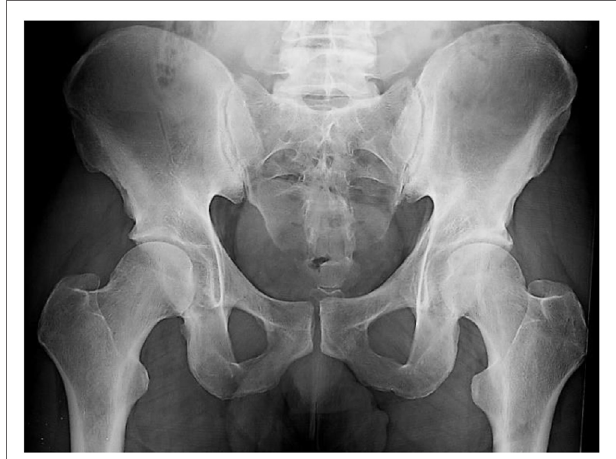
FiGURe 1 | A 40-year-old male with a 3-year history of low back pain with short duration morning stiffness. Treatment with nonsteroidal anti- inflammatory drugs showed partial improvement. B27 is negative and C-reactive protein is 20 mg/L. Pelvic radiograph demonstrates suspicious changes of the right sacroiliac joint (SIJ) and minimal abnormalities of the left SIJ, not fulfilling the 1984 modified New York criteria for the diagnosis of ankylosing